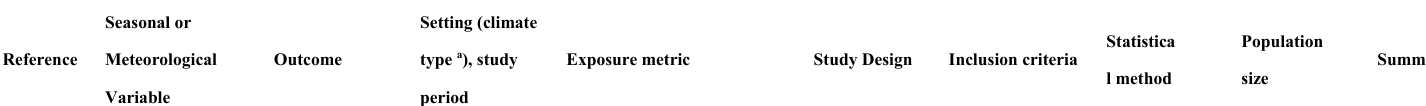
Table 2. Associations between meteorology and the length of gestation, including preterm